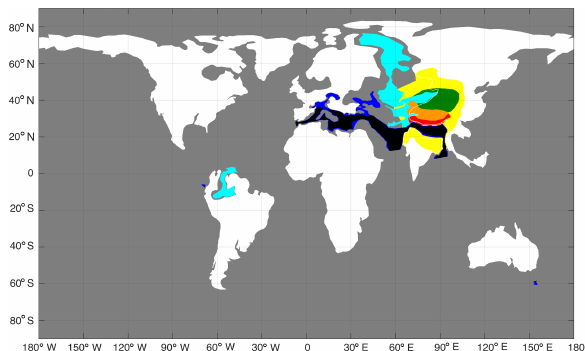
Figure 3. Second stage of the reconstruction: topography and bathymetry with adjustments to polar regions and a lowering of sev- eral mountain ranges. Changes can be noted mainly in Greenland, Antarctica, the Neotethyan Ocean, the Andes and the Himalayas.